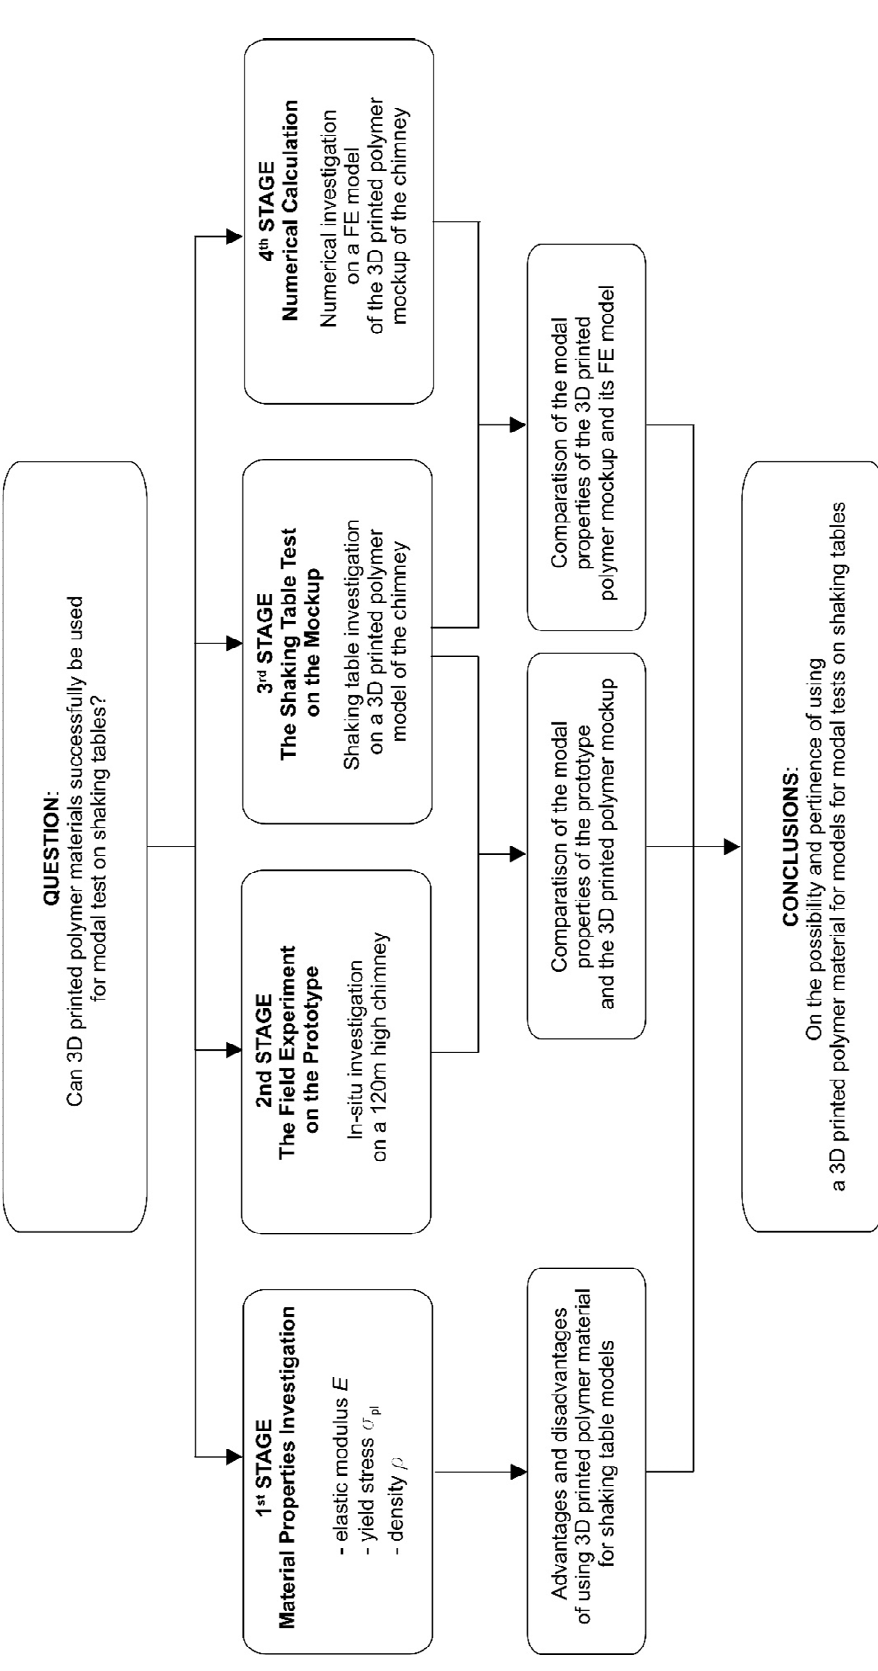
Figure 1. The general concept and the main stages of the research.